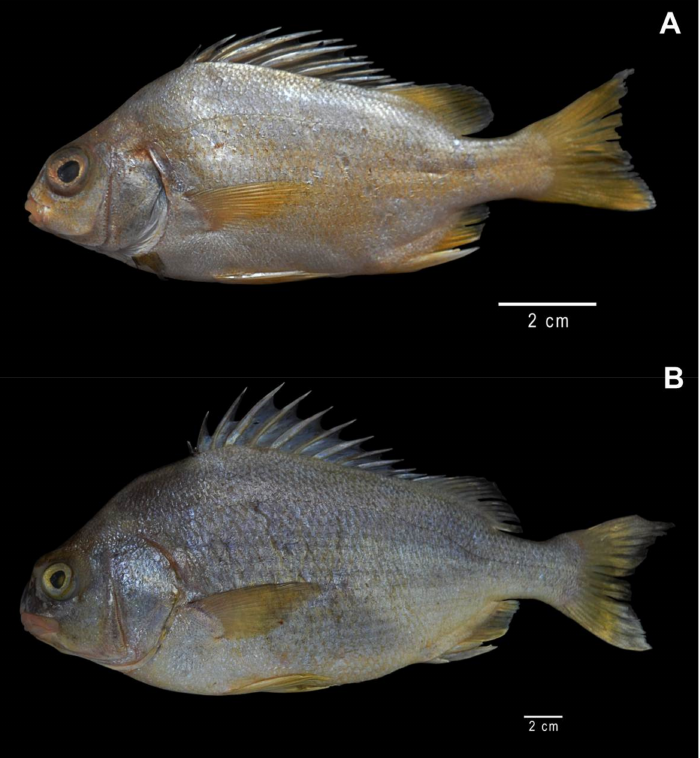
Figure 1. The specimen of Genyatremus luteus (BLOCH, 1790). ( A ): juvenile specimen; ( B ): adult